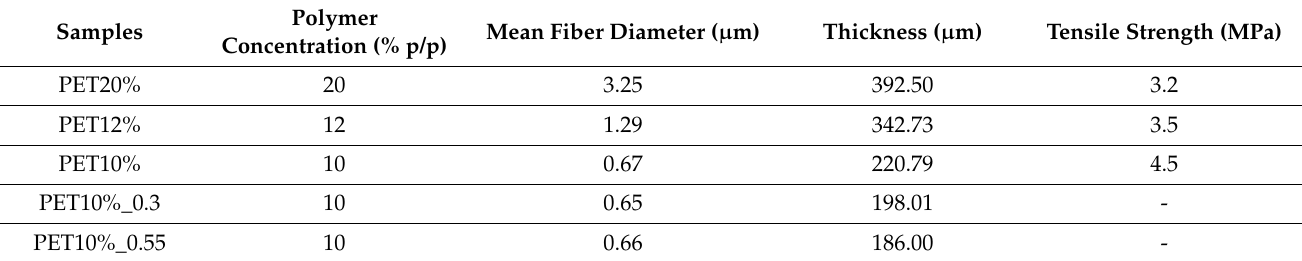
Table 2. Morphological characteristics of the